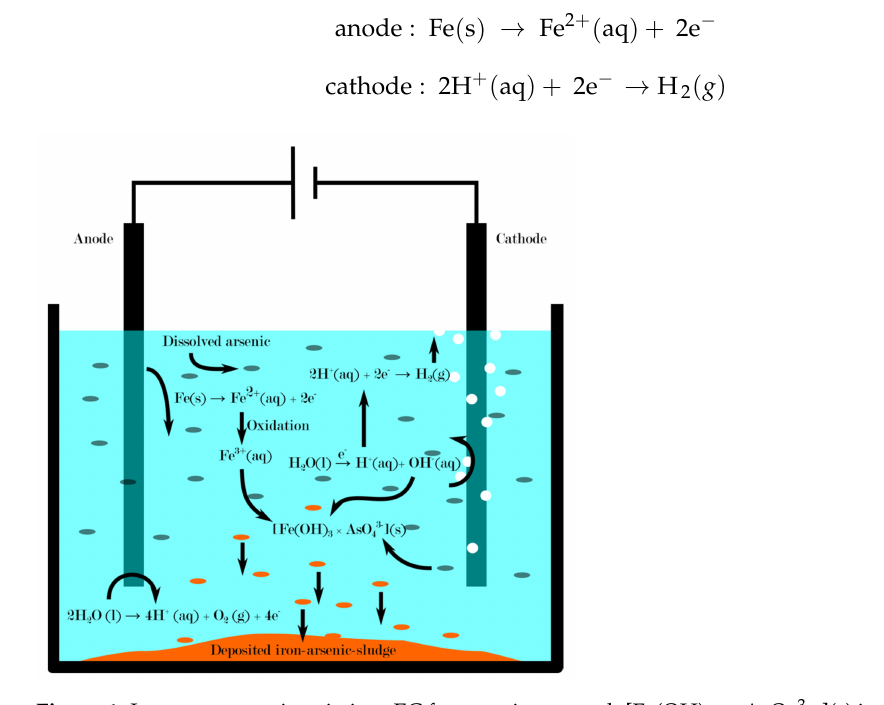
Figure 1. Important reactions in iron EC for arsenic removal. [Fe(OH) 3 × AsO 43 − ](s) is representative for the various